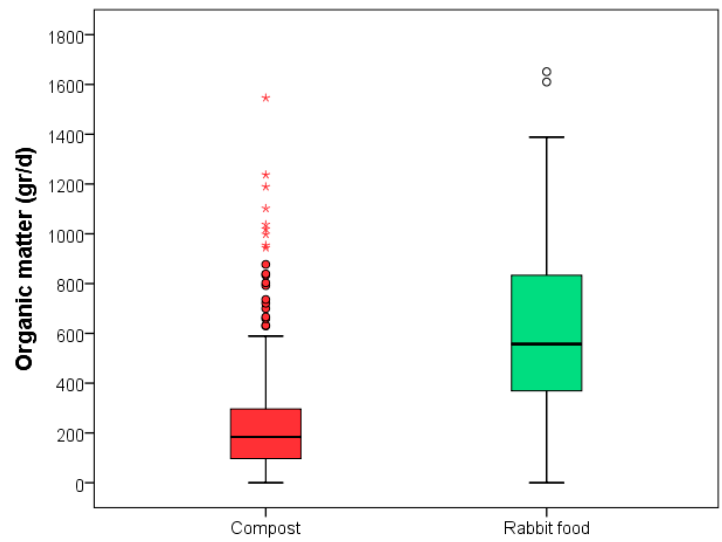
Figure 3. Distribution of the daily quantities of organic remains according to the destination.